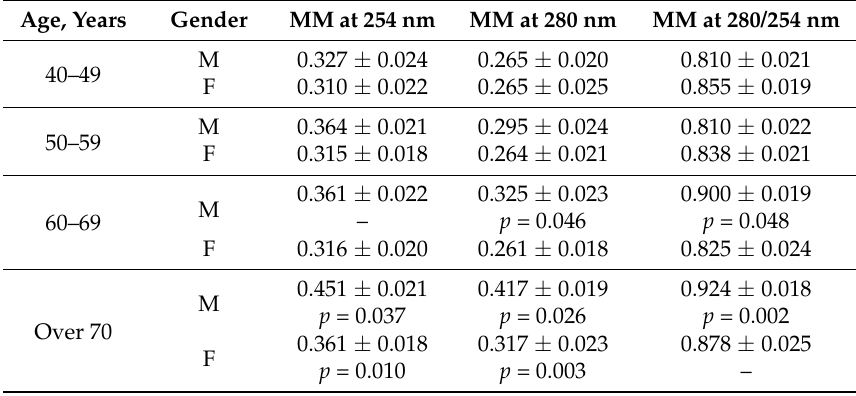
Table 1. MM levels under normal conditions depending on gender and age.